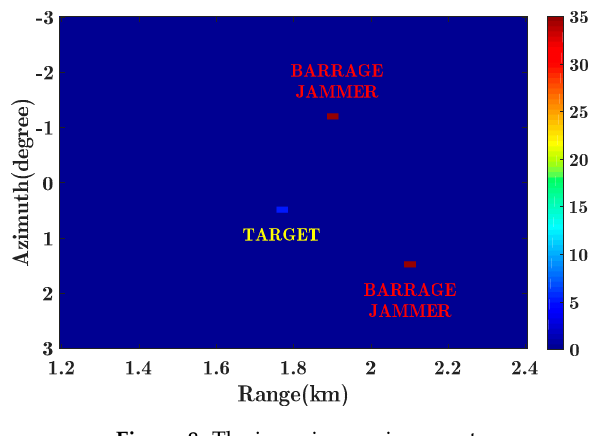
Figure 8. The jamming environment.